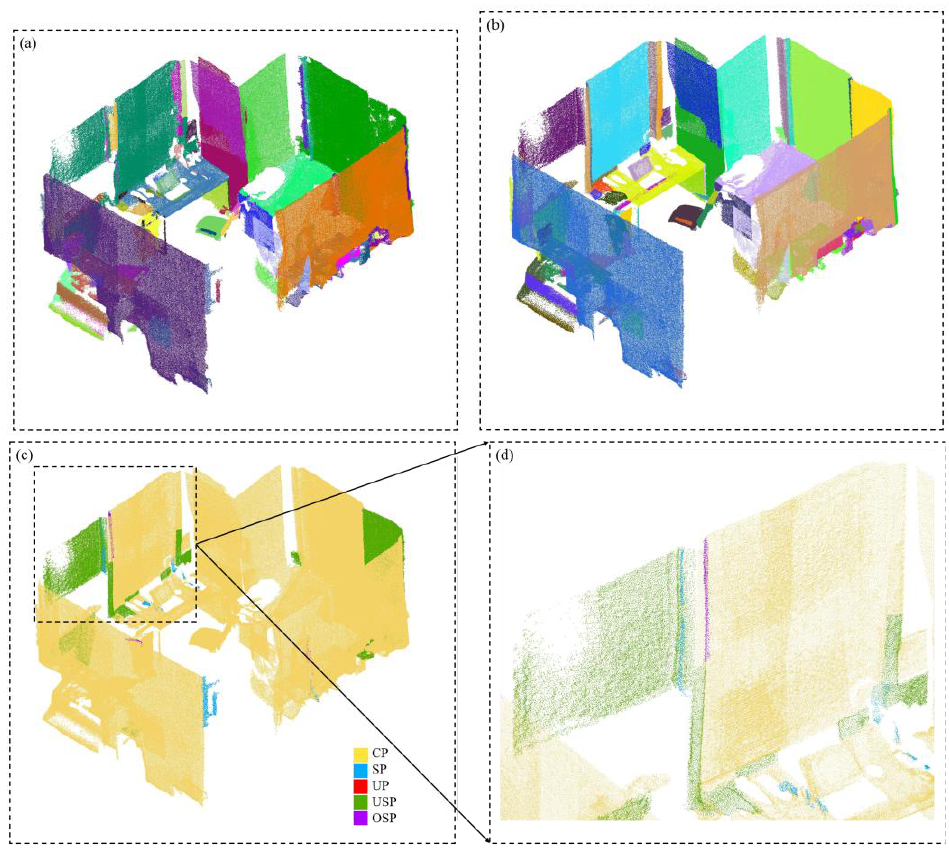
Figure 15. Plane-segmentation results for the Lab dataset: ( a ) proposed method, ( b ) ground truth,